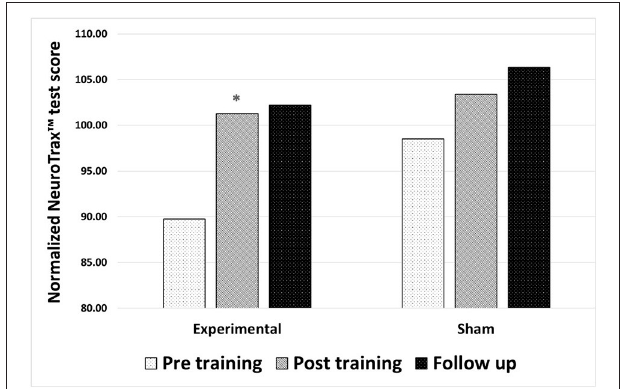
FIGURE 1 | Changes in memory performance after either true neurofeedback training or sham neurofeedback training. Composite memory scores from the NeuroTrax TM tests in 3 time points: before training, after training and 30 days after training (follow up). Results of both the experimental and the sham neurofeedback groups are shown. A significant improvement in memory performance was observed for participants in the experimental group alone * P <